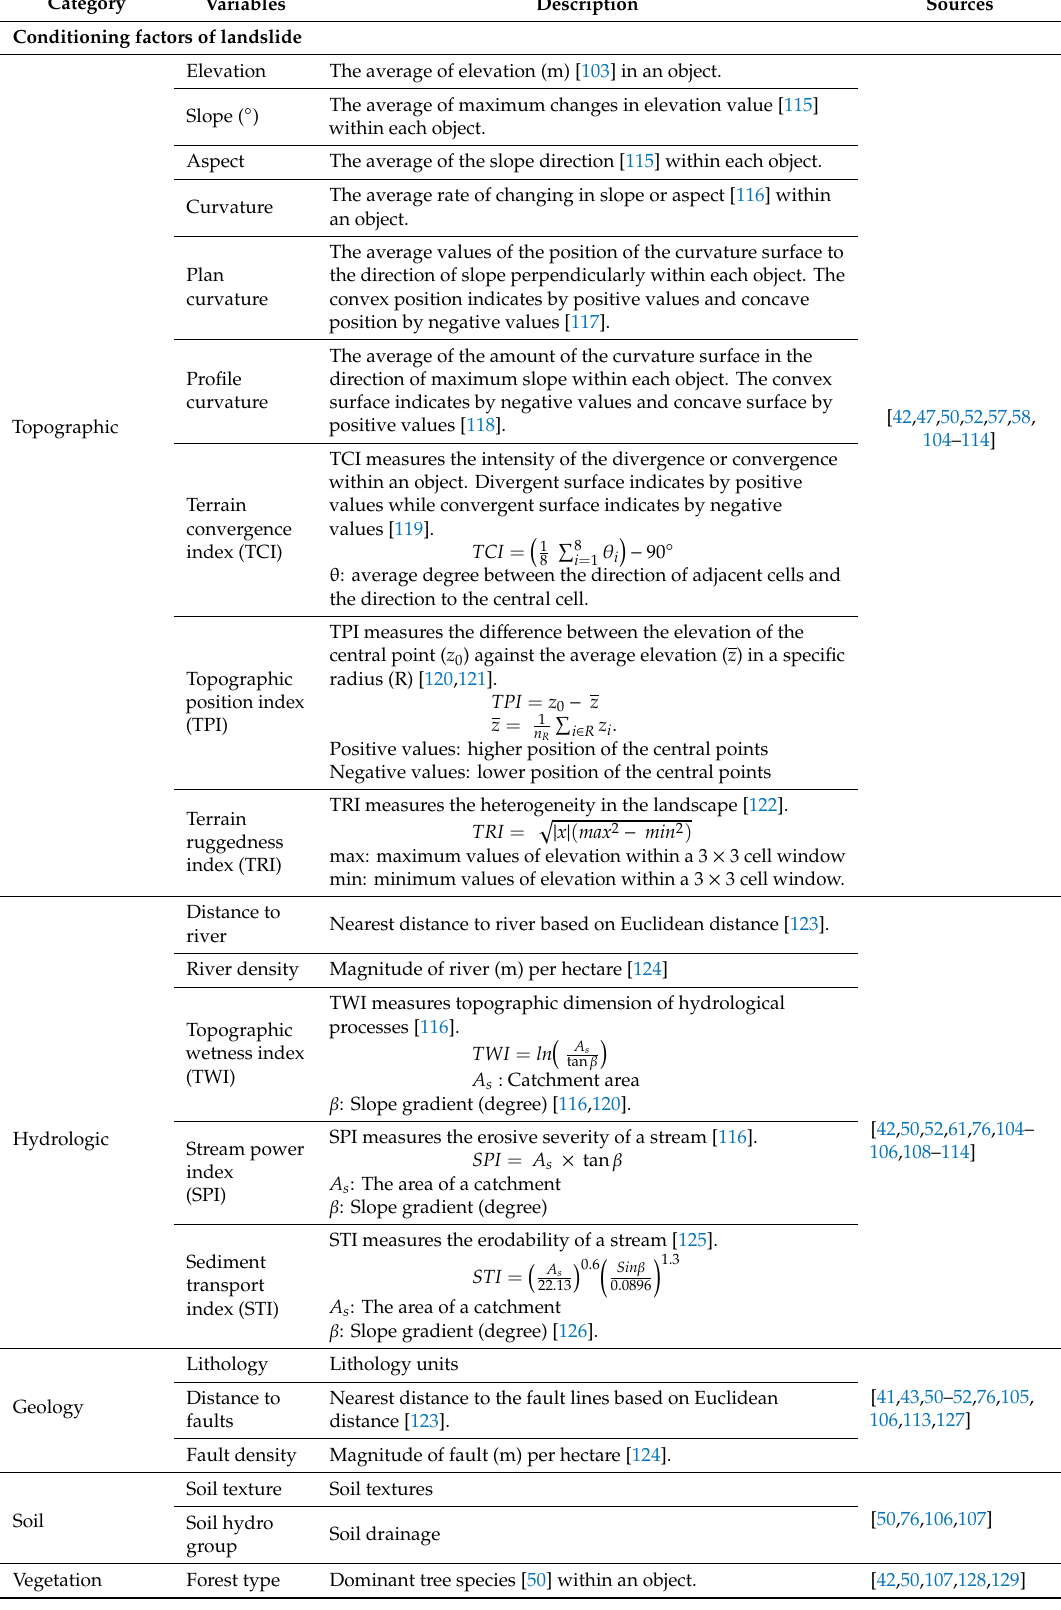
Table 1. Conditioning factors for mapping landslide susceptibility used in NE